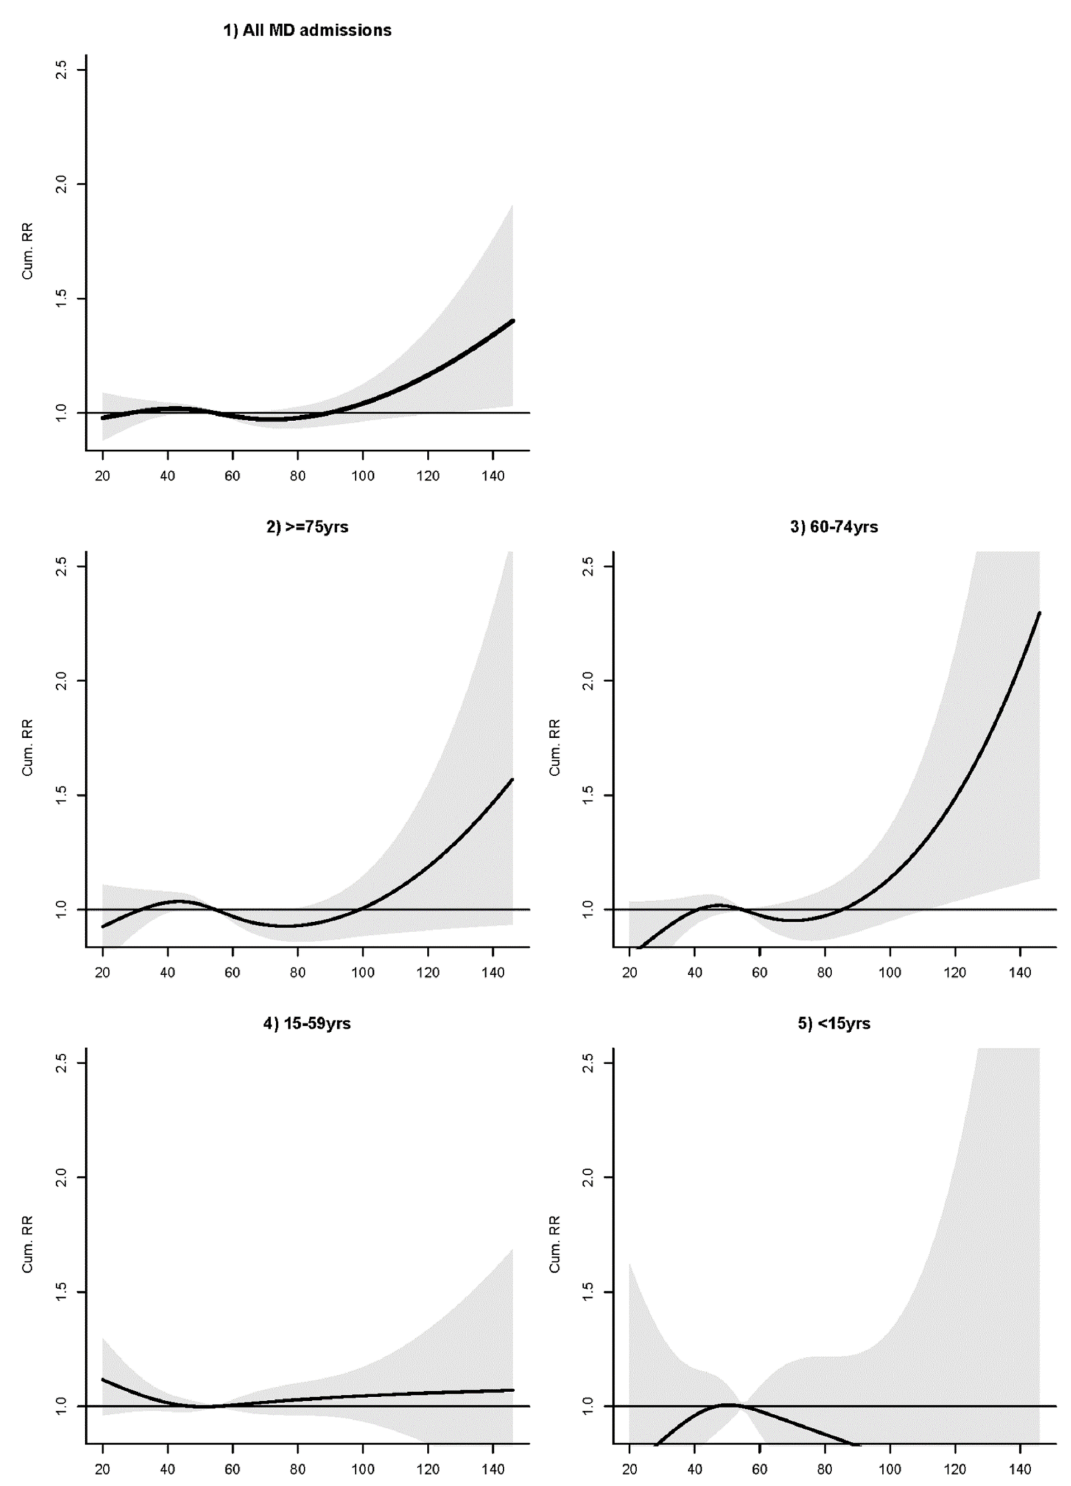
Figure A1. RR-NO2 ( µ g/m 3 ) plots in lagged 0–8 days for ( 1 ) overall mental disorders (MD)